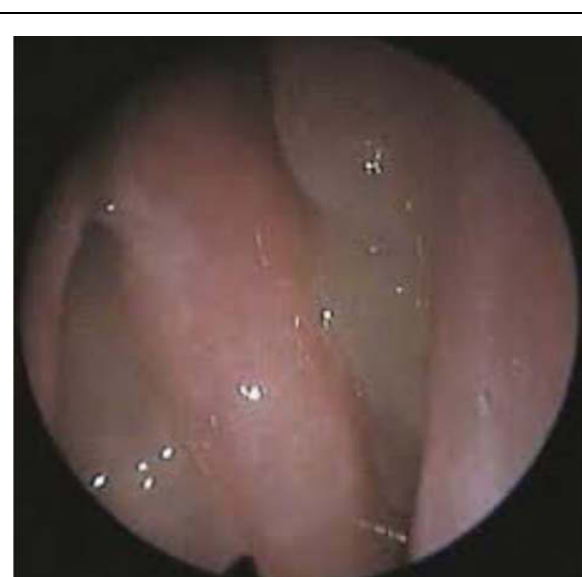
Endoscopic view of right nasal cavity with a polyp extending from the middle meatus (Meltzer 2), but, during operative examination, polyps from sphenoethmoidal recess were found (Meltzer 3).